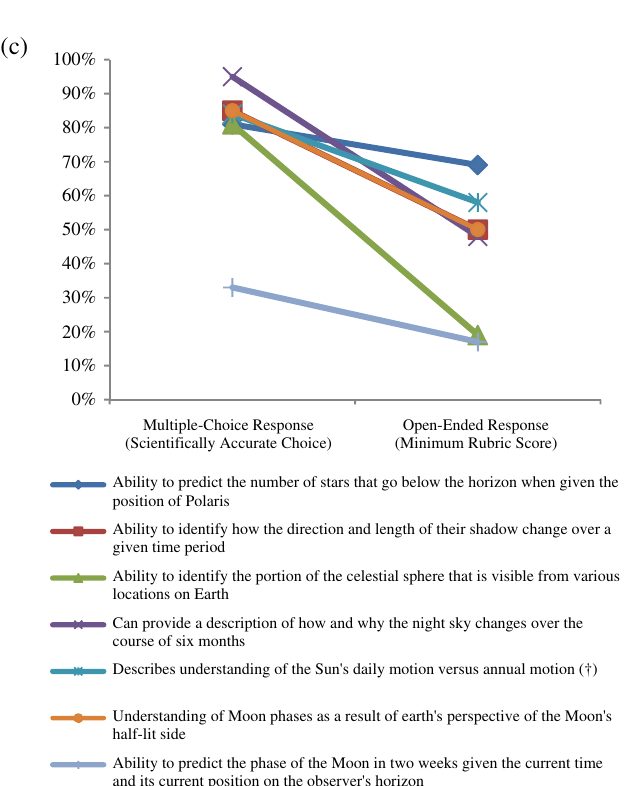
FIG. 1. Percentage of students meeting the minimum criteria (a) PRE-LAB, (b) POST-LAB, and (c) POST-COURSE. We denote when students choosing the correct multiple-choice response are statistically related to the students attaining the minimum rubric score with a